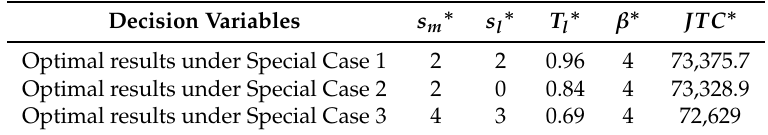
Table 5. Optimal outcomes of the corresponding decision variables under Special Cases.